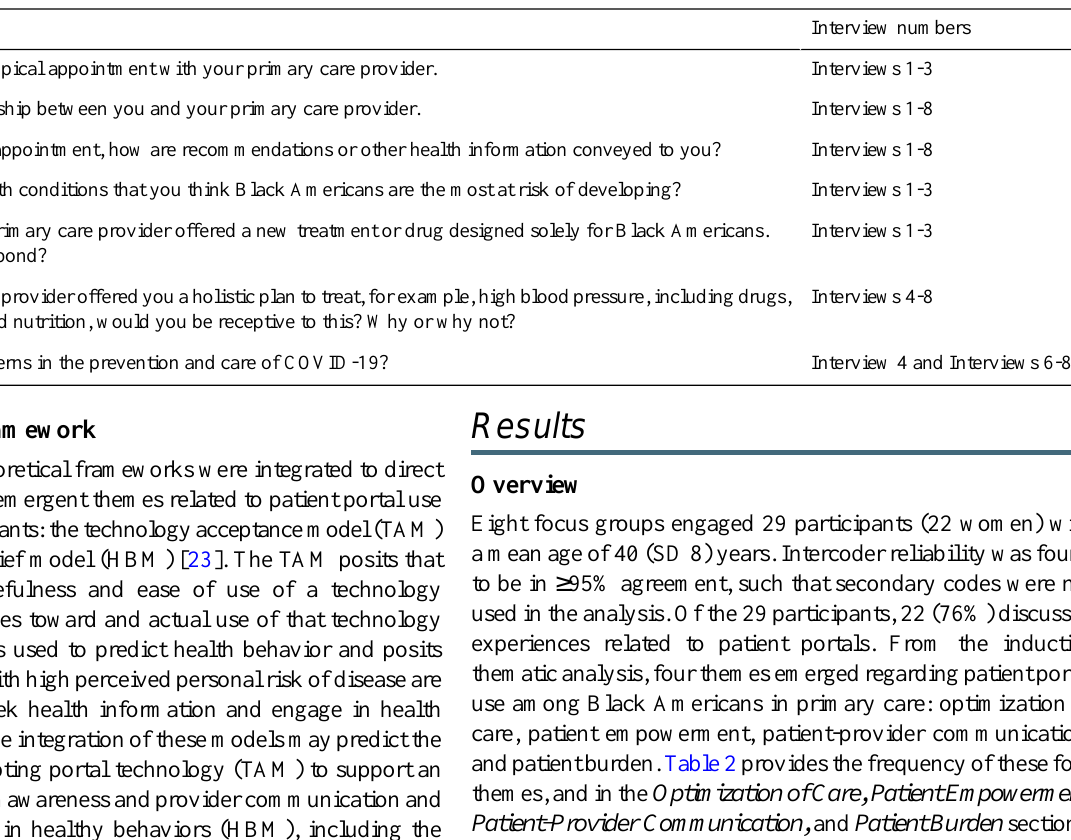
Table 1. Interview guide for 8 remote focus groups.